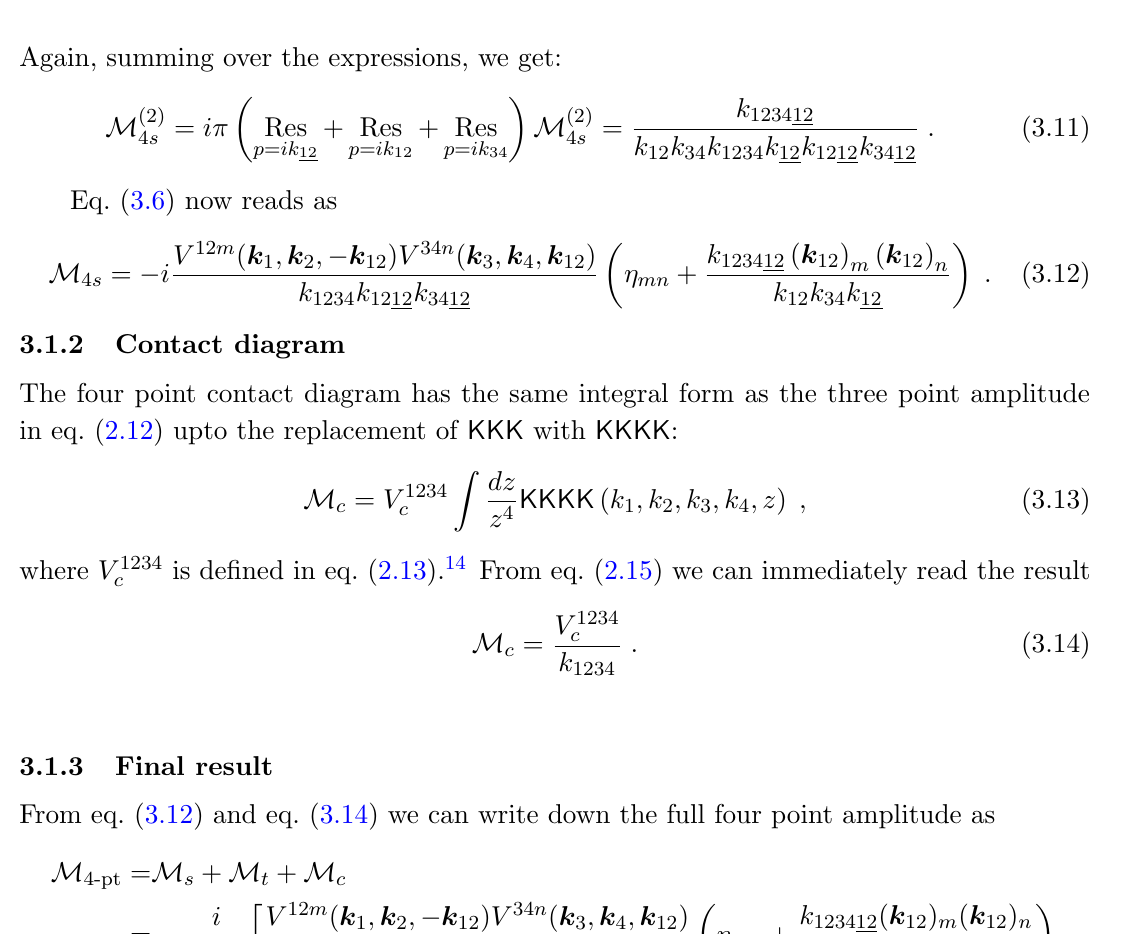
Figure 3 . The four point contact 1